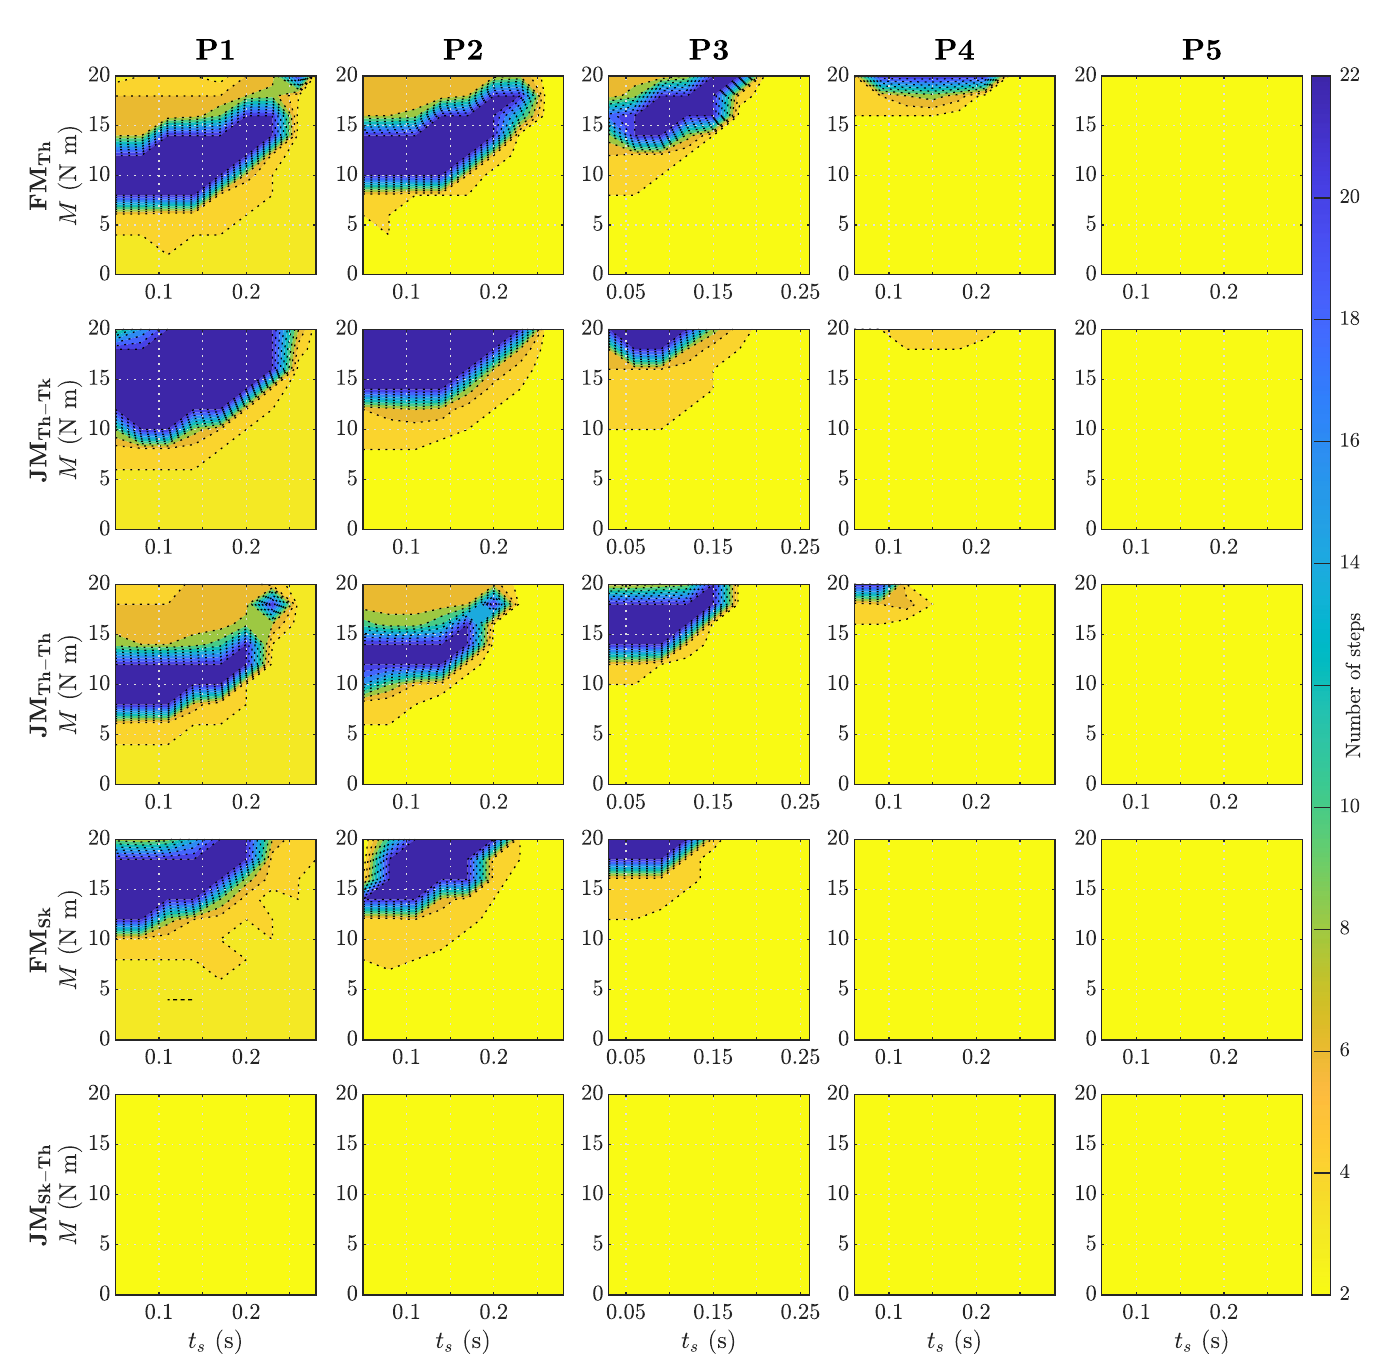
Fig 4. Number of steps n as a function of assistance parameters (magnitude M and start time t ). The low end of the colour scale (pale yellow) represents s unsuccessful recoveries in which model took only two steps before falling. The high end of the colour scale (dark blue) represents the maximum number of steps the model took in the unperturbed case (more than ten steps represents full recovery, FR). The recovery responses of a free moment with action on thigh (FM Th ), joint moment with action on thigh and reaction on trunk (JM Th-Tk ), joint moment with action on thigh and reaction on contralateral thigh (JM Th-Th ), free moment with action on shank (FM Sk ), and joint moment with action on shank and reaction on thigh (JM Sk-Th ) to perturbations P1–5 are shown.